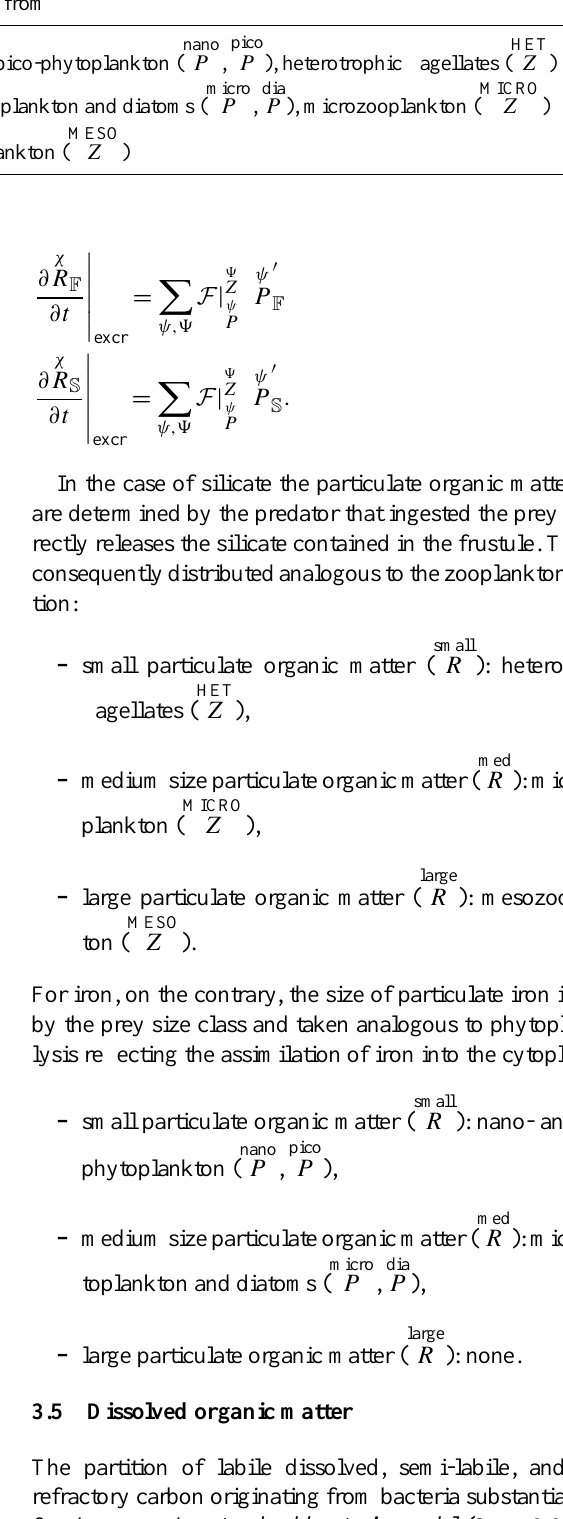
Table 2. Particulate organic matter and its origin. POM